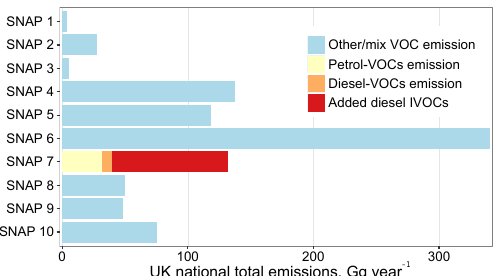
Figure 2. Annual UK NMVOC emissions by SNAP sector (Table 1) as specified in the NAEI (for the year 2012), with the SNAP7 emis- sions subdivided into petrol and diesel vehicles, and with the addi- tional diesel-associated IVOC emissions input to the model in this study shown in